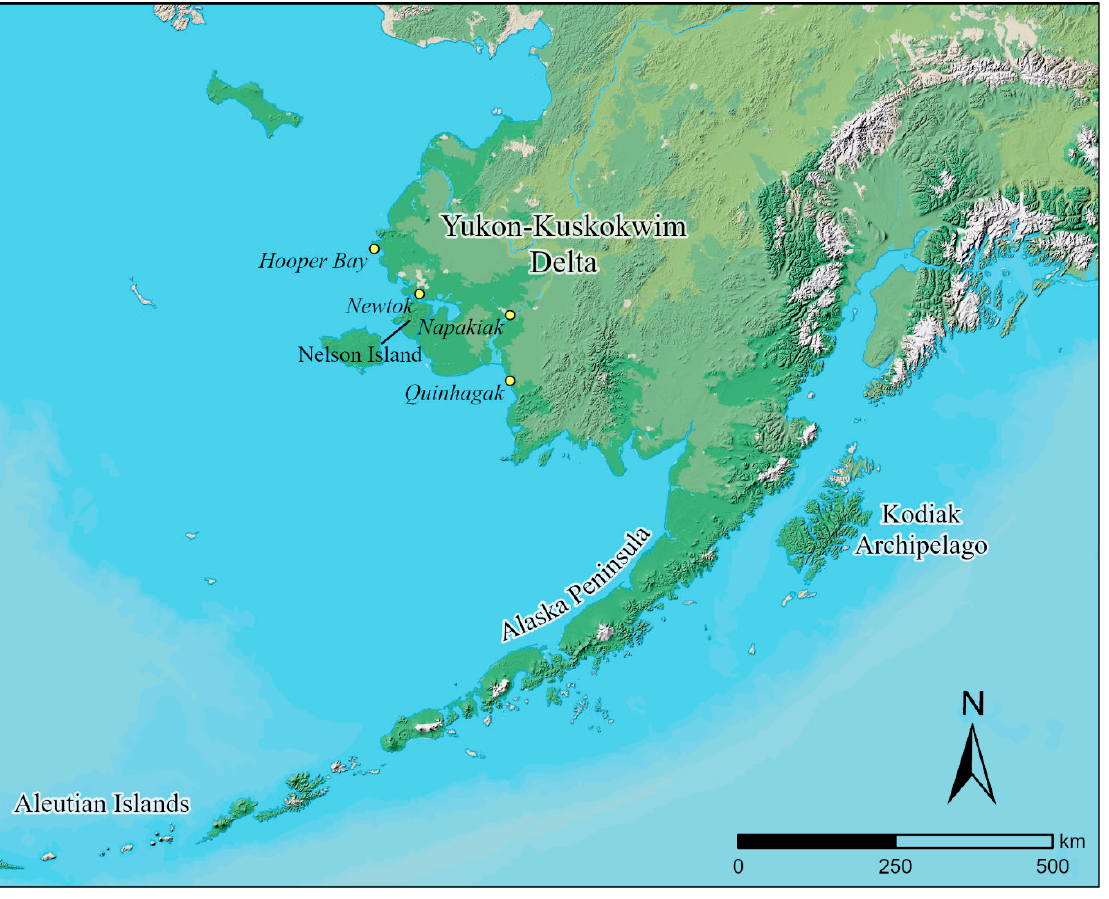
Figure 1. Southwest Alaska is home to many Alaska Native groups who must now contend with the devastating effects of climate change on their homes and heritage.